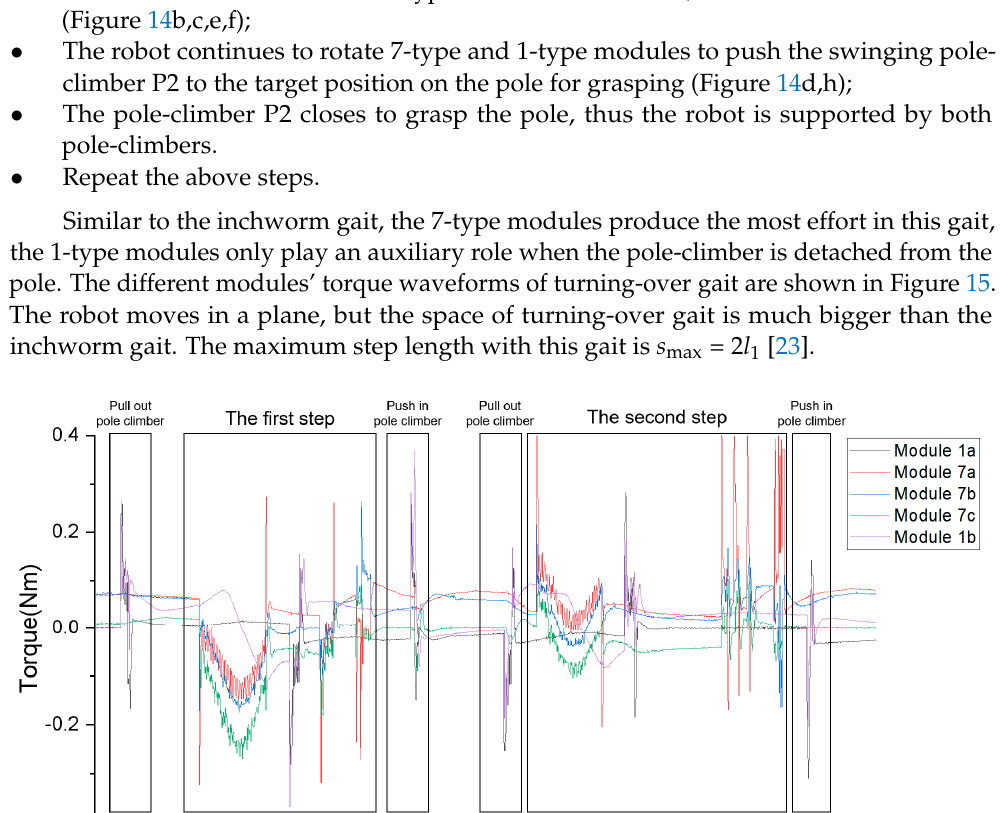
Figure 14. Turning-over gait. ( a ) Initial state, ( b ) motion 1, ( c ) motion 2, ( d ) completed state, ( e ) front elevation of initial motion, ( f ) front elevation of motion 1, ( g ) front elevation of motion 2, ( h ) front elevation of completed state